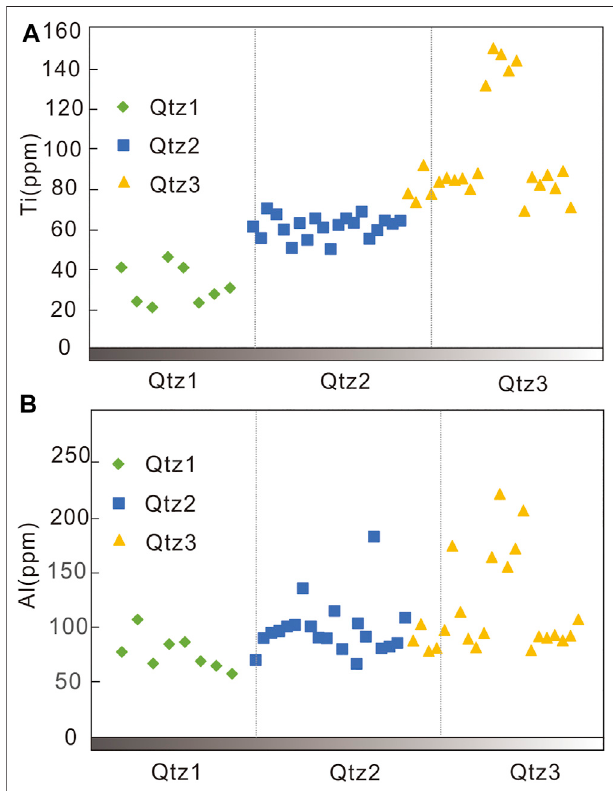
FIGURE6| ContentofAlandTicontentsinthethreequartzgenerations from the Hongniu – Hongshan deposit.